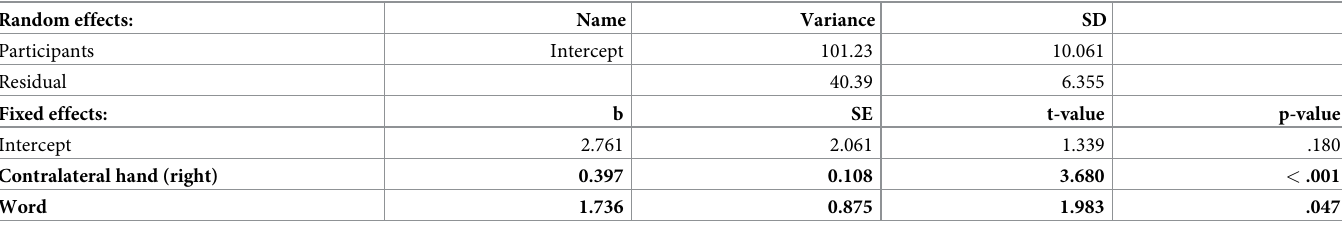
Table 12. Model 3.2. Effect of Direction on the left grip force (after controlling for the contralateral force) in the time window 250–300 ms (Experiment 3). Random